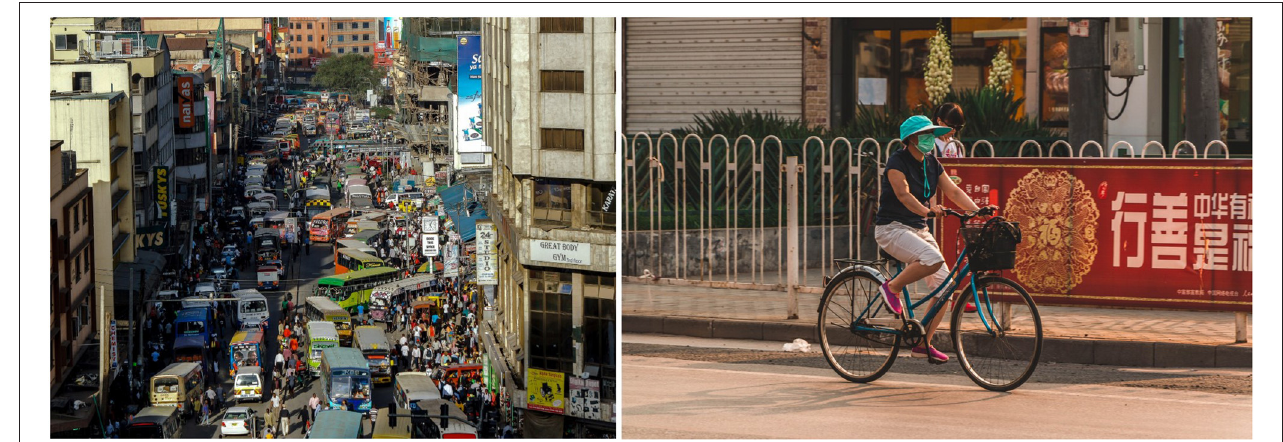
FIGURE 1 | Urban populations are projected to double by 2030. How can we make current and future cities more sustainable while also maintaining and preserving biological diversity and ecosystem